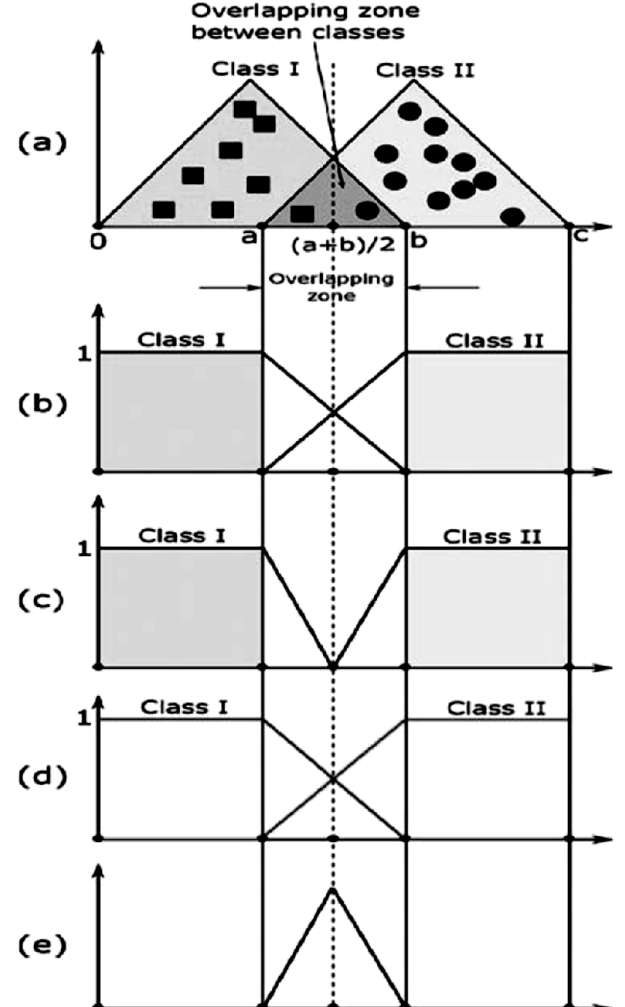
Figure 6. A look at how NS is like fuzzy logic. ( a ) The triangular fuzzy membership function of classes I and II; ( b ) a fuzzy verification; ( c – e ) are the neutrosophic truth, falsehood, and indeterminacy parts, respectively.